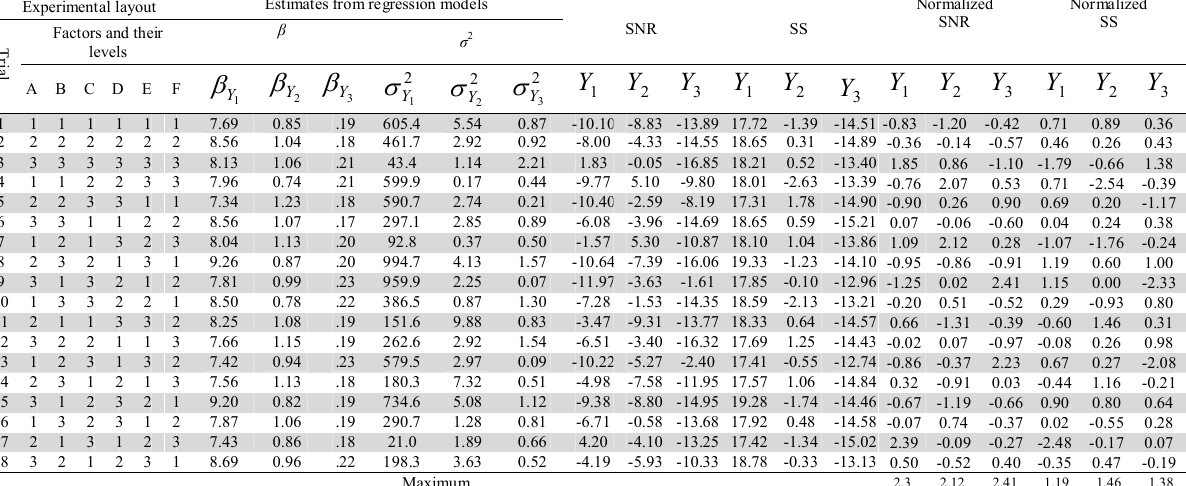
Normalized Normalized SNR SS